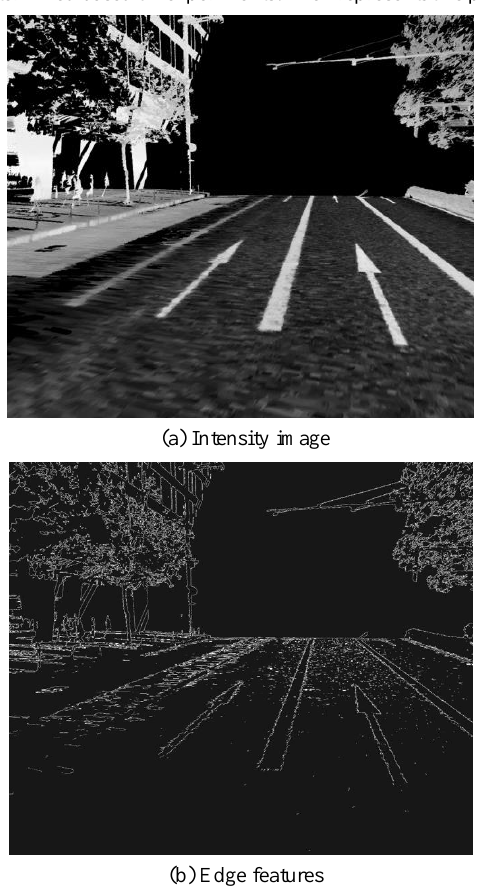
Figure 11. Edge features extracted from intensity image